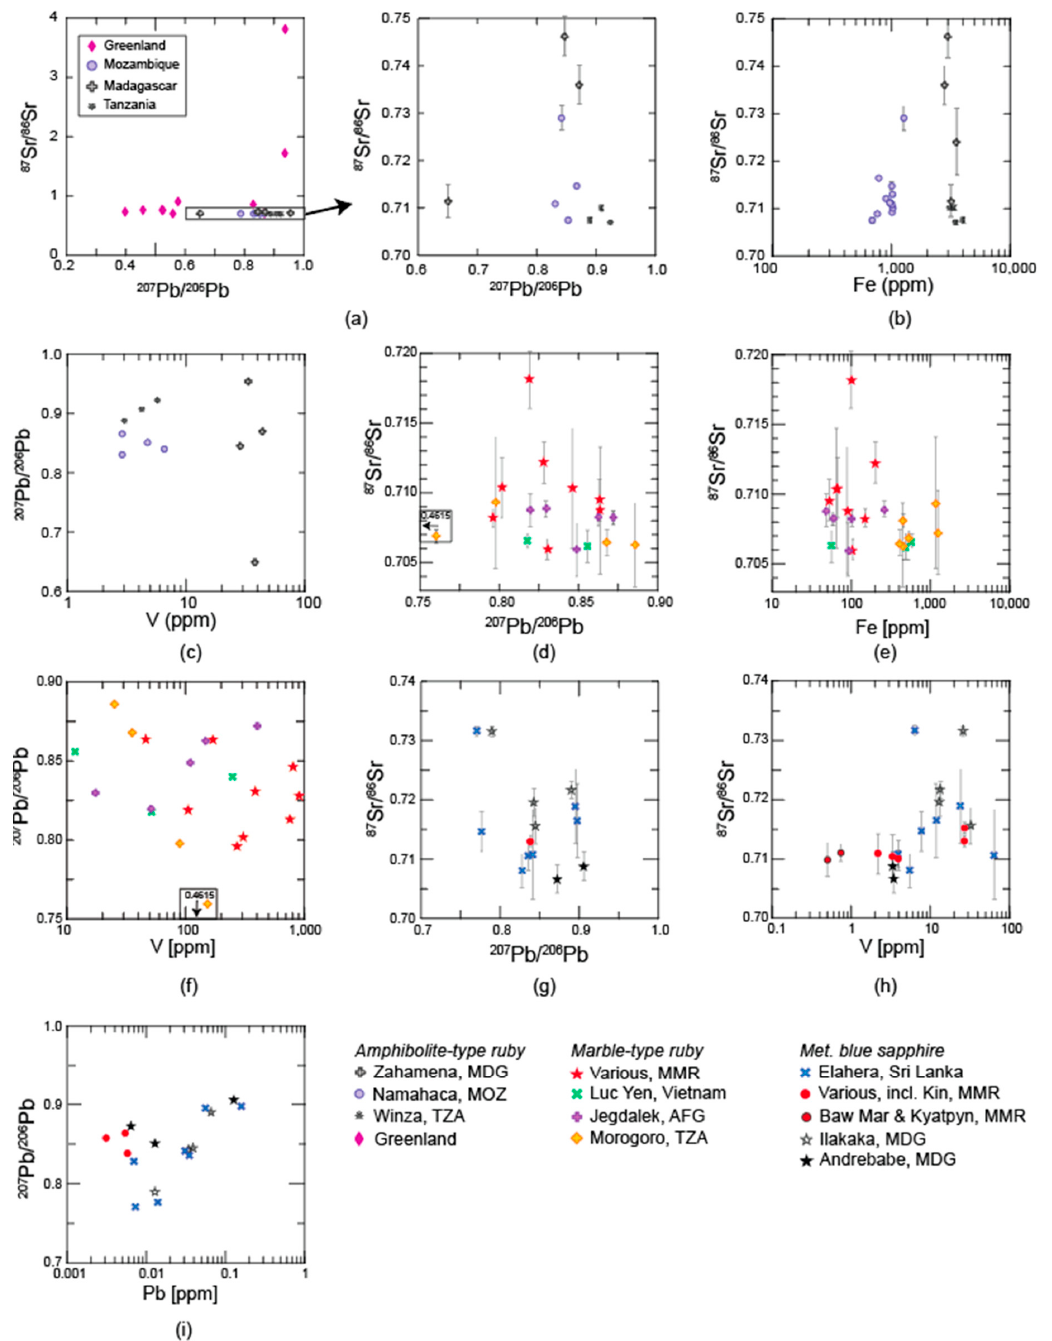
Figure 16. Radiogenic isotope characteristics of rubies and blue sapphires analyzed in this study. ( a ) 87 Sr / 86 Sr versus 207 Pb / 206 Pb, ( b ) 87 Sr / 86 Sr versus Fe (ppm), and ( c ) 207 Pb / 206 Pb versus V (ppm) of amphibolite-type rubies. ( d ) 87 Sr / 86 Sr versus 207 Pb / 206 Pb, ( e ) 87 Sr / 86 Sr versus Fe (ppm), and ( f ) 207 Pb/ 206 Pb versus V (ppm) of marble-type rubies. ( g ) 87 Sr/ 86 Sr versus 207 Pb/ 206 Pb, ( h ) 87 Sr/ 86 Sr versus V (ppm), and ( i ) 207 Pb/ 206 Pb versus Pb (ppm) of metamorphic blue sapphires. Where error bars are absent, uncertainties are smaller than the symbols.